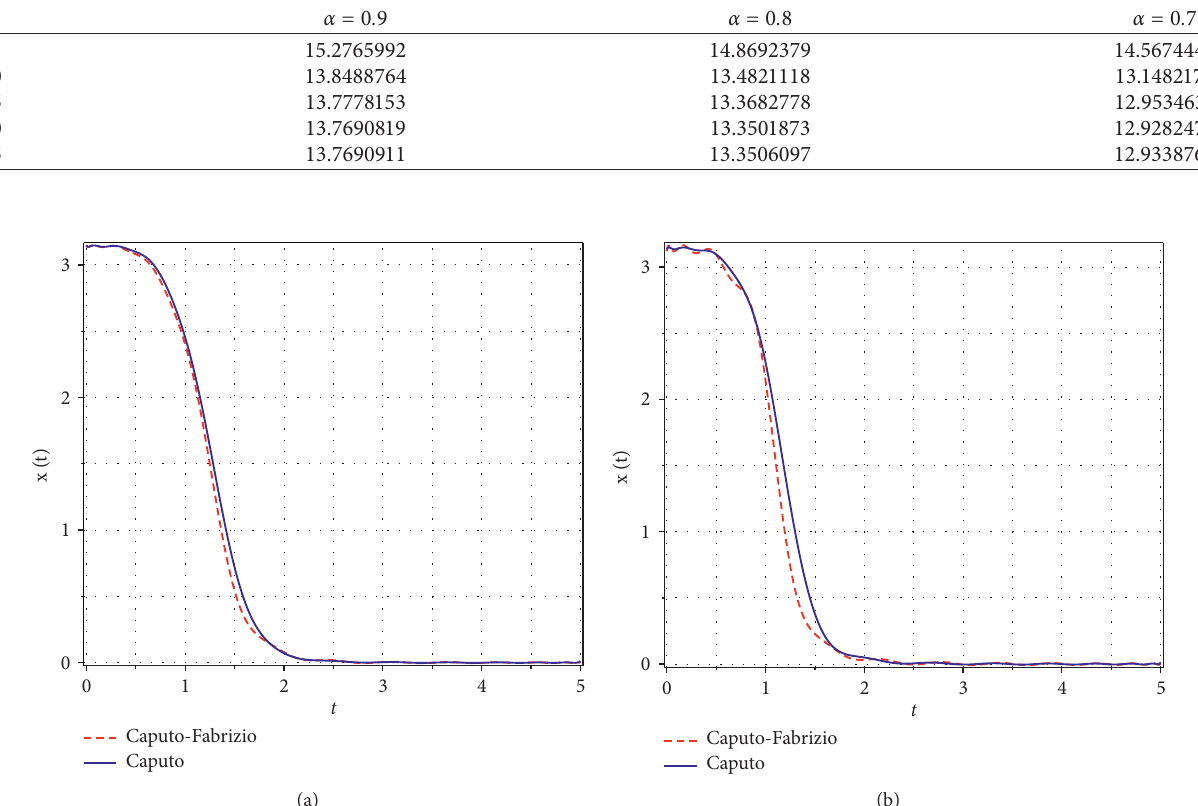
Figure 6: Simulation curves of x ( t ) for α � 0 . 7 and α � 0 . 5 in Example 4 within the Caputo and Caputo–Fabrizio fractional derivatives. (a) Simulation curves of x ( t ) for α � 0.7. (b) Simulation curves of x ( t ) for α �